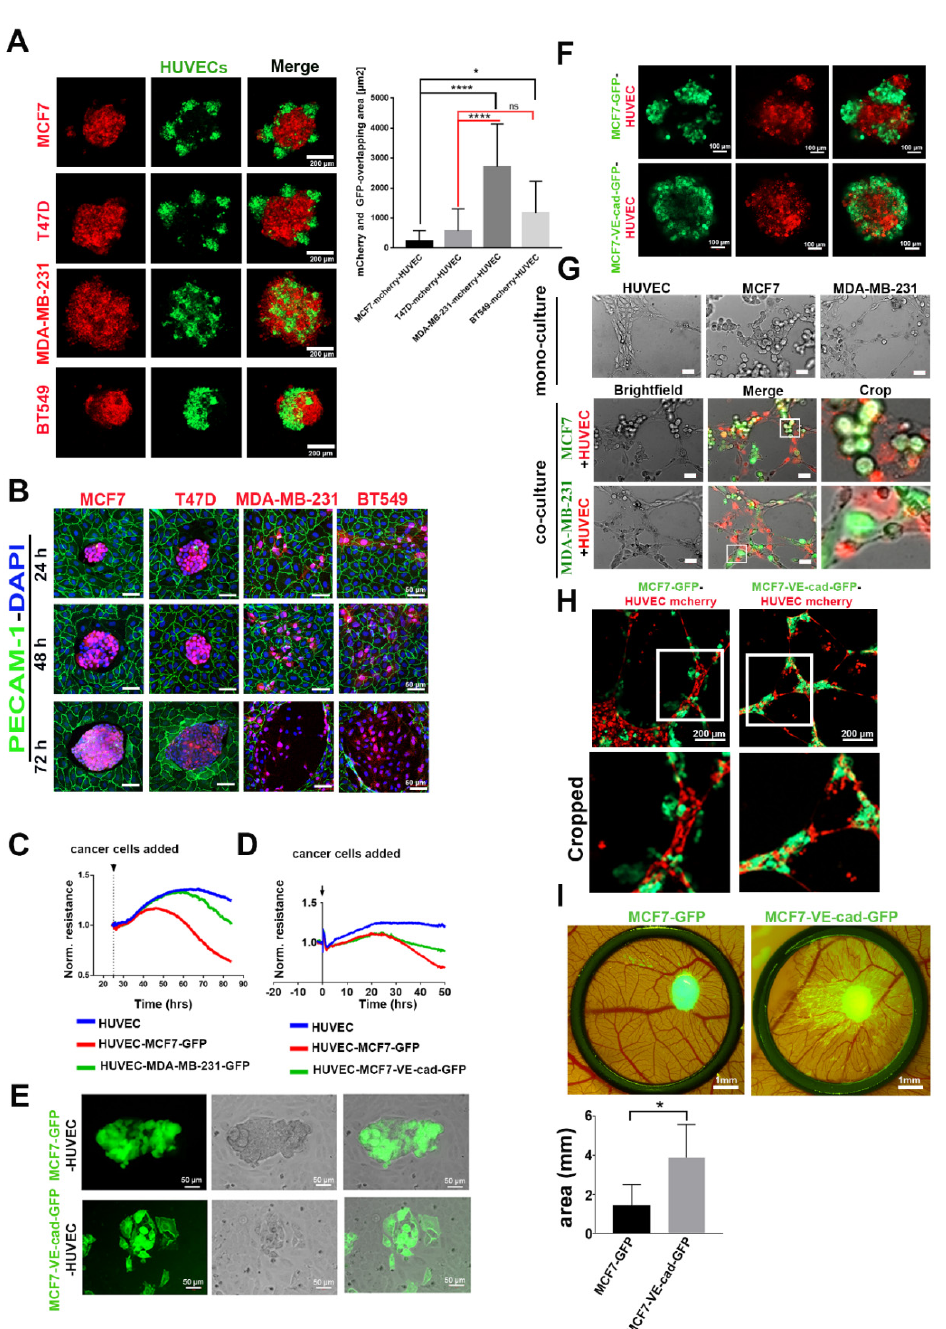
Figure 4. Expression of VE ‐ cadherin in MCF7 cells promoted the integration of cancer cells into the HUVEC monolayer and endothelial tube ‐ like structures. ( A ) Three ‐ dimensional co ‐ culture of HUVEC ‐ GFP cells with E ‐ cadherin ‐ expressing cancer cell lines (MCF7 ‐ mCherry and T47D ‐ mCherry) and E ‐ cadherin ‐ negative cell lines (MDA ‐ MB ‐ 231 ‐ mCherry and BT549 ‐ mCherry). The graph shows the quantification of the colocalized regions between cancer cells and HUVECs in spheroids, which were measured by using the CellProfiler software. E ‐ cadherin ‐ containing cancer cells intermingled with HUVECs less than cancer cells expressing other cadherins. For the evaluation of overlapping area, the numbers of images analyzed were as follows: n = 17 MCF7 ‐ mCherry, n = 14 T47D ‐ mCherry, n = 13 MDA ‐ MB ‐ 231 ‐ mCherry, and n = 14 BT549 ‐ mCherry. Mean values ± SD are shown (* p ≤ 0.05;